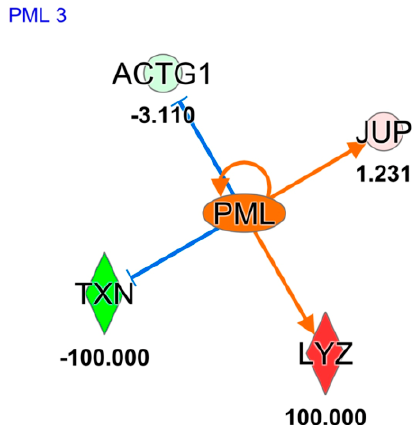
Figure 5. Upstream regulator analysis, based on proteins identified and quantified in EVs sorted in POAG and CTRL tears, using Ingenuity Pathway software. Orange and blue shapes represent predicted activation or inhibition, respectively. The predicted relationship between genes may lead to direct activation (orange solid lines) or direct inhibition (blue solid lines). Red and green color indicates genes significantly increased and decreased in expression, respectively, while the number represent the fold change log. Symbols used in the figure represent: Enzyme symbolized as vertical rhombus and “other” protein symbolized as circle. Abbreviations: Junction plakoglobin (JUP ); Thioredoxin ( TXN ); Actin, cytoplasmic 2 ( ACTG1 ); and Lysozyme C ( LYZ ).